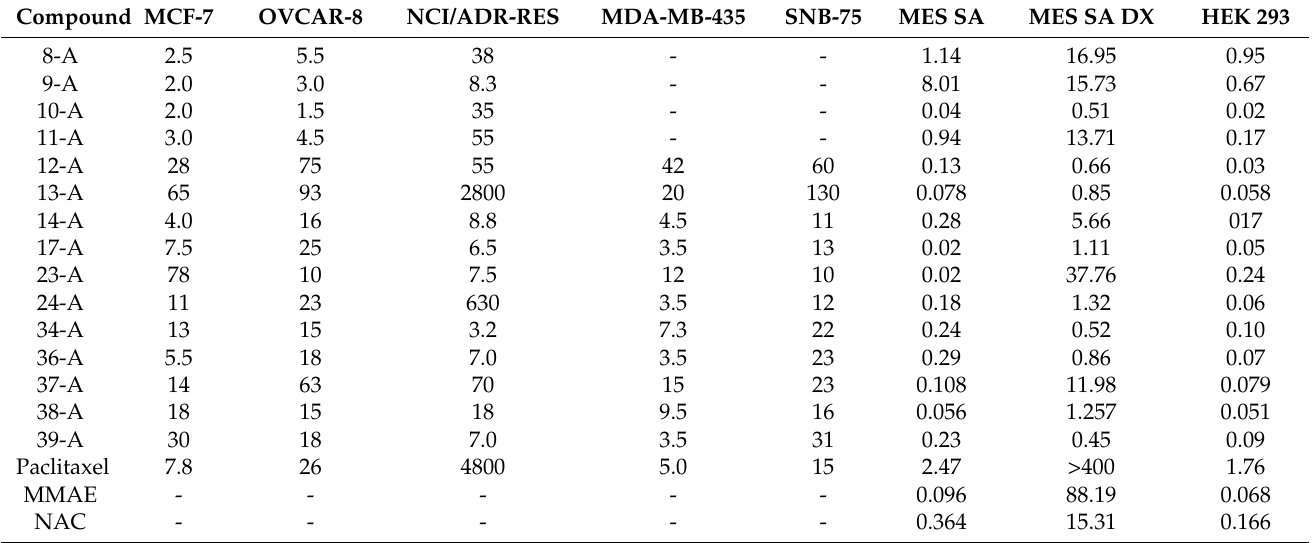
Table 5. Cytotoxicity values for 12, 13-Aziridinyl epothilones in various cancer cell lines (IC 50 in